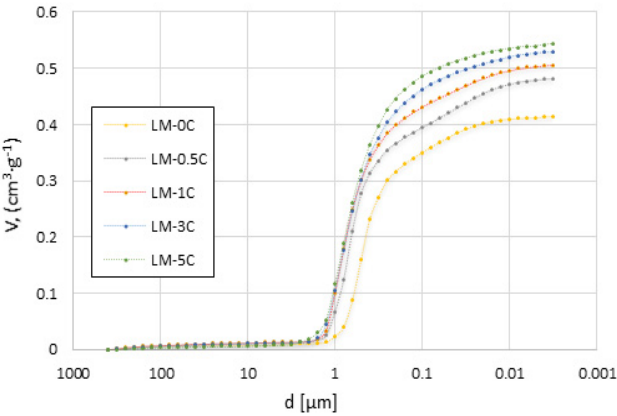
Figure 3. Cumulative volume of intruded mercury versus pore diameter for tested lime-metakaolin pastes.